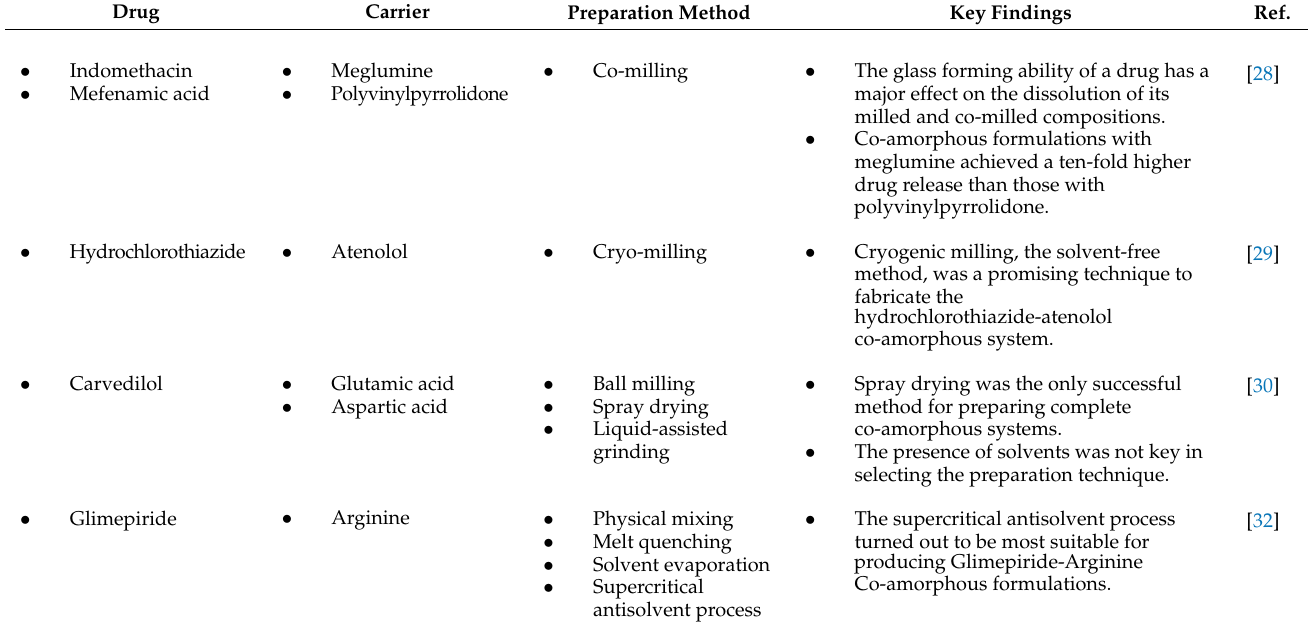
Table 1. Recent publications that employed various methods to prepare co-amorphous systems. Drug Carrier Preparation Method Key